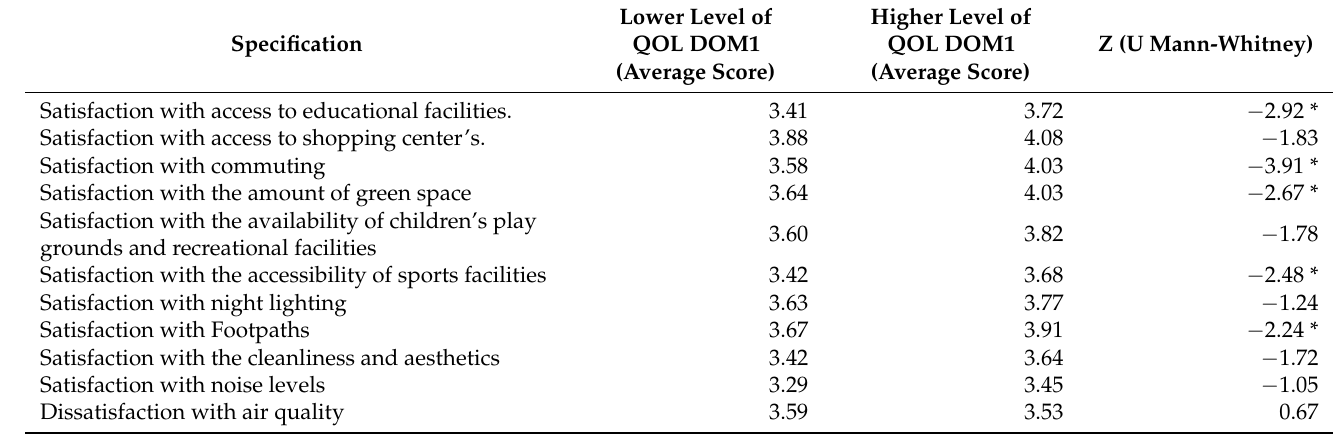
Table 3. Level of satisfaction with selected elements of urban infrastructure concerning the level of quality of life in the physical domain (DOM1) (Mann-Whitney U test).